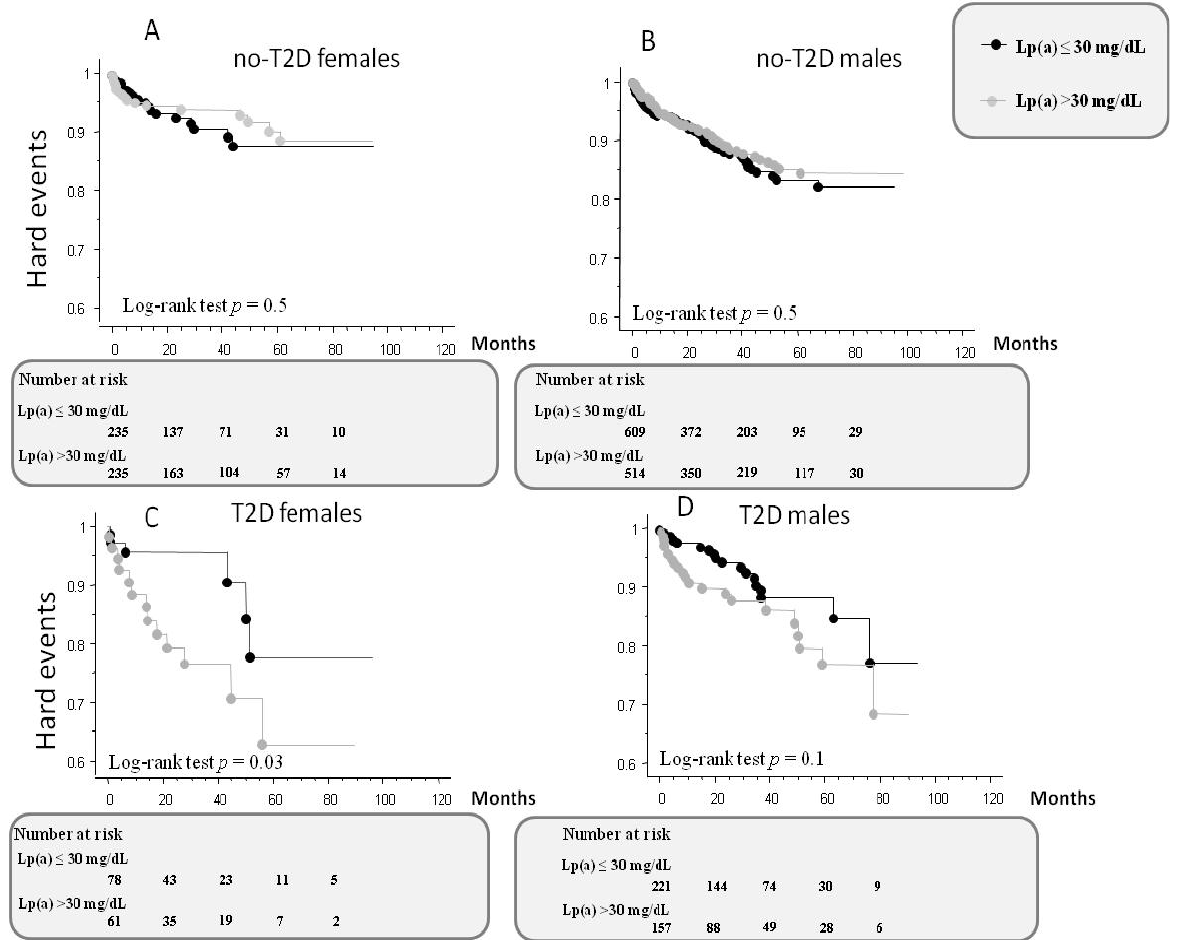
Figure 2. Kaplan–Meier survival curves according to Lp(a) levels in female and male patients with and without T2D ( A – D ), with hard events (mortality and non-fatal myocardial infarction) as end points. Table 3. Univariate and multivariate COX analysis for HEs in T2D female